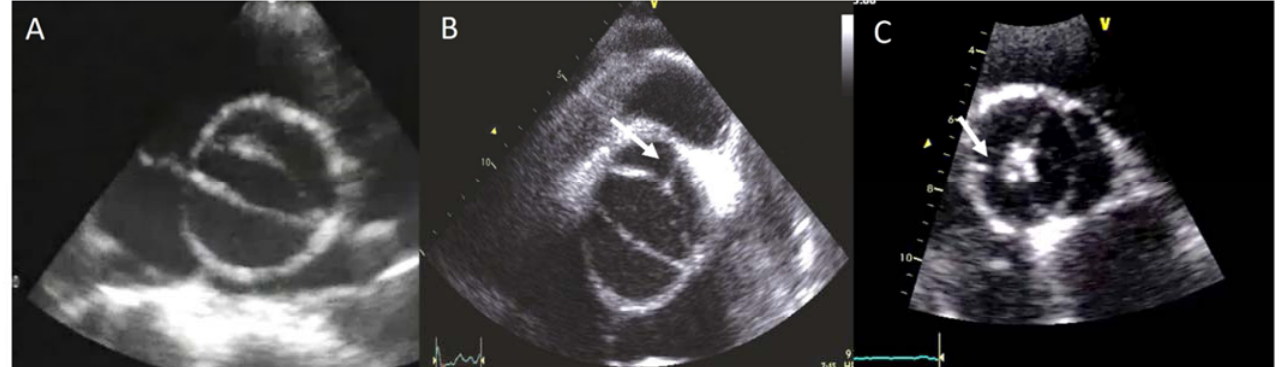
Figure 1. Most frequent types of BAV by TTE. ( A ) BAV without raphe type antero − posterior; ( B ) RC − LC fusion with raphe (arrow); ( C ) RC − NC fusion with raphe (arrow).